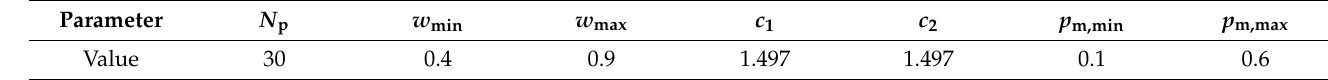
Table 1. Parameters of the EPSO optimization algorithm.